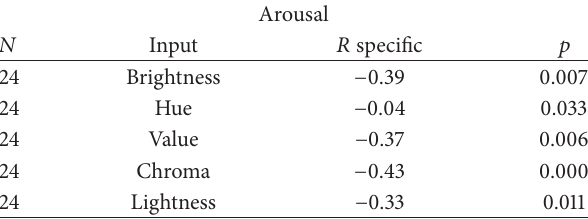
Table 2: Arousal